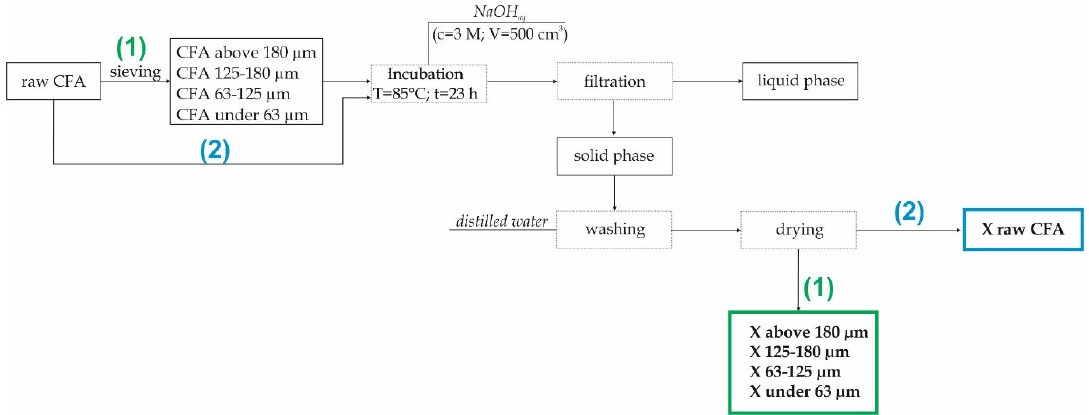
Figure 2. The synthesis of zeolite X from CFA (coal fly ash) preceded by a sieving process.